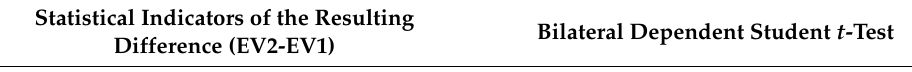
Table 10. The table of statistical indicators of the difference in percentage distribution of weight on